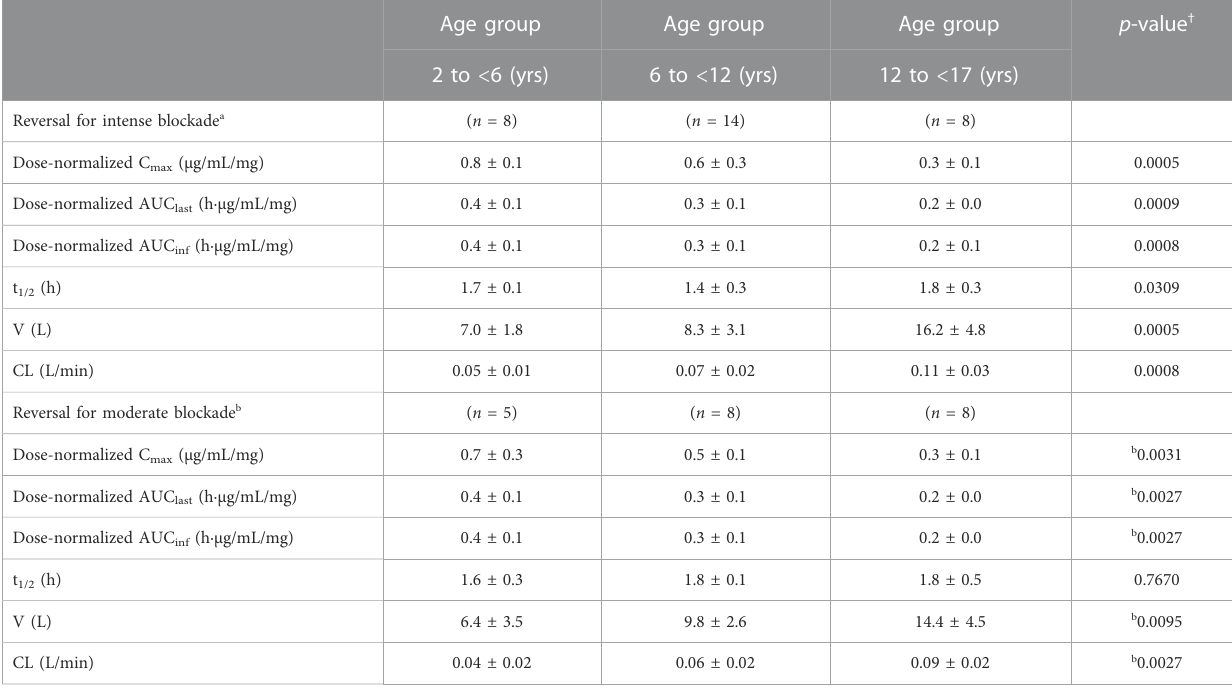
TABLE 3 Summary of pharmacokinetic parameters of sugammadex according to age.